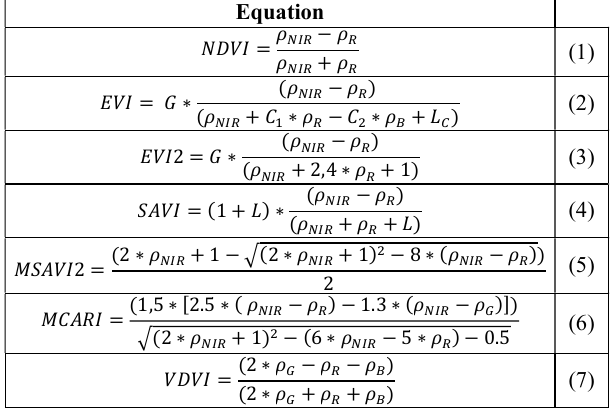
Table 2: Vegetation indexes extracted for both Sentinel-2 images, where, ρ B,G,R,NIR = the reflectance value of the given band; L = soil line adjustment factor; G = gain factor; C 1 e C 2 = aerosol resistance coefficients; Lc = vegetation correction factor.